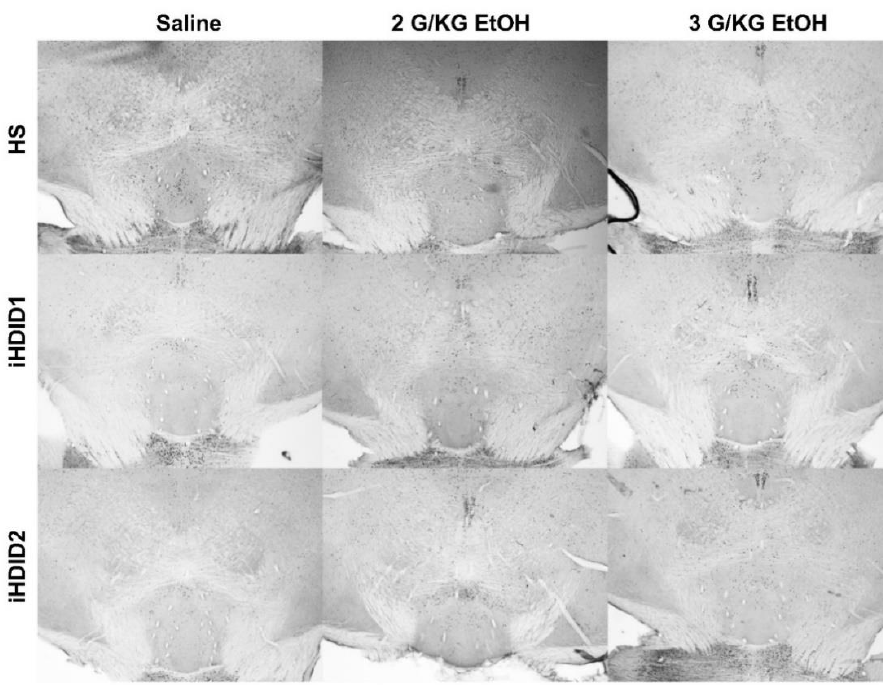
genotype and treatment types.